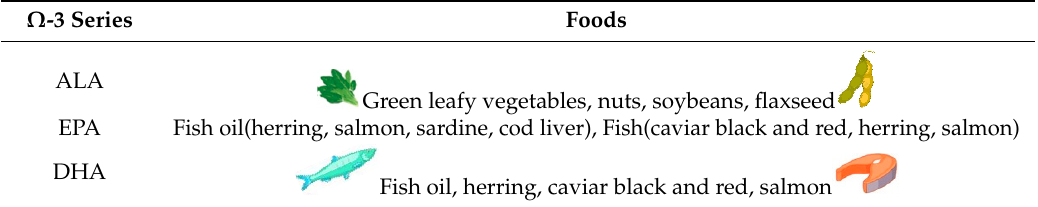
Table 1. Main dietary sources of ω -3 fatty acids.